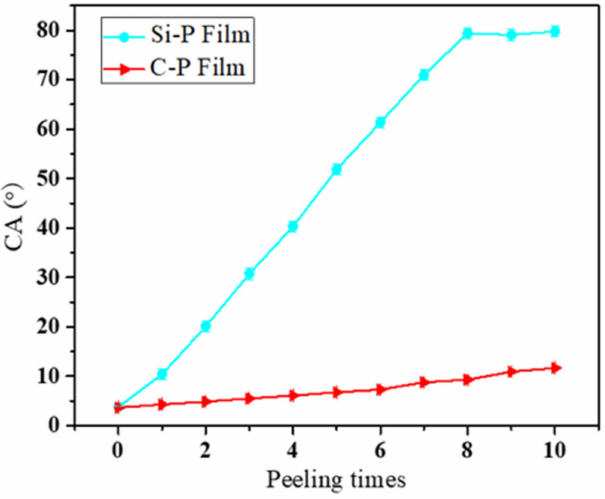
Figure 12. Relationship between CA and the peeling times for C-P and Si-P